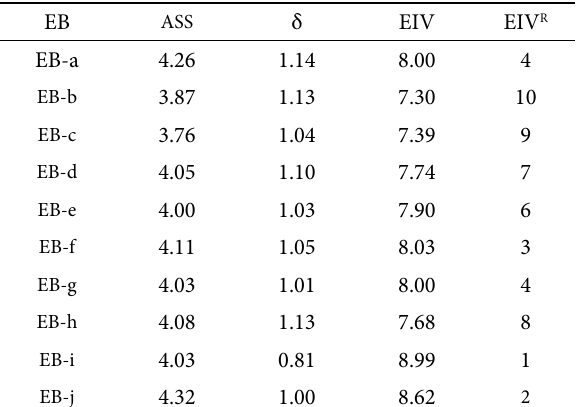
Table 6. Calculated Average Effectiveness Score (ASS) and Effectiveness Index Value (EIV) for participant responses to strategies of implementing EMS in the Nigerian construction industry